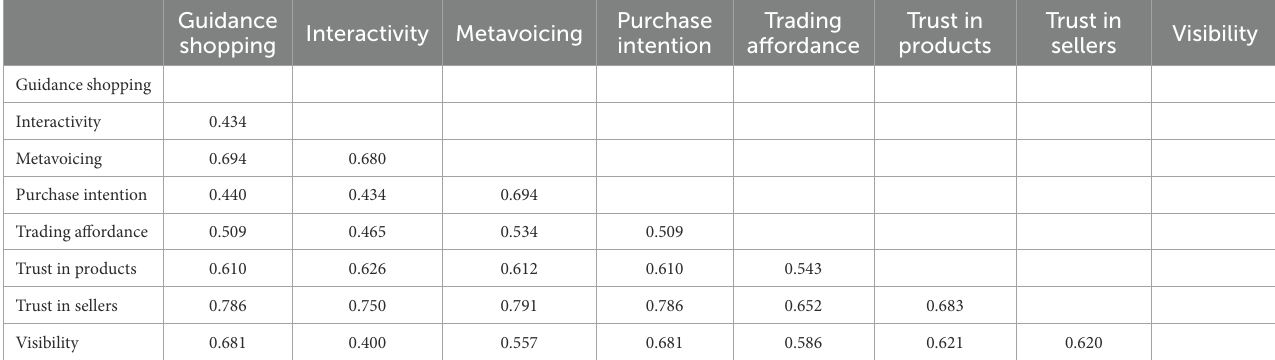
TABLE 3 Discriminant validity-HTMT.